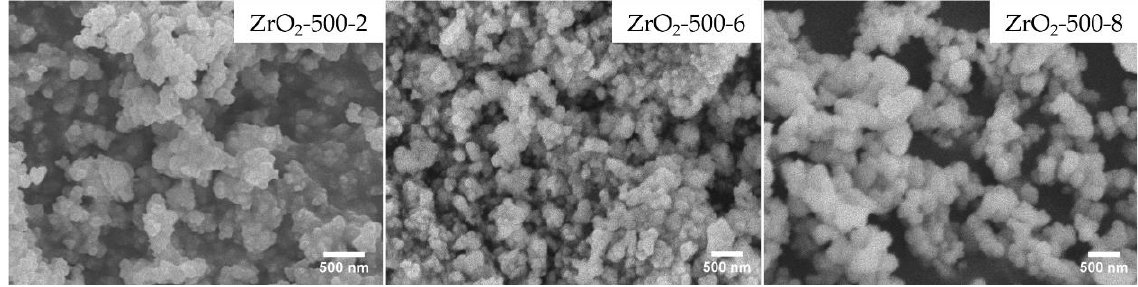
Figure 2. SEM images of UiO-66 particle after calcination at 500